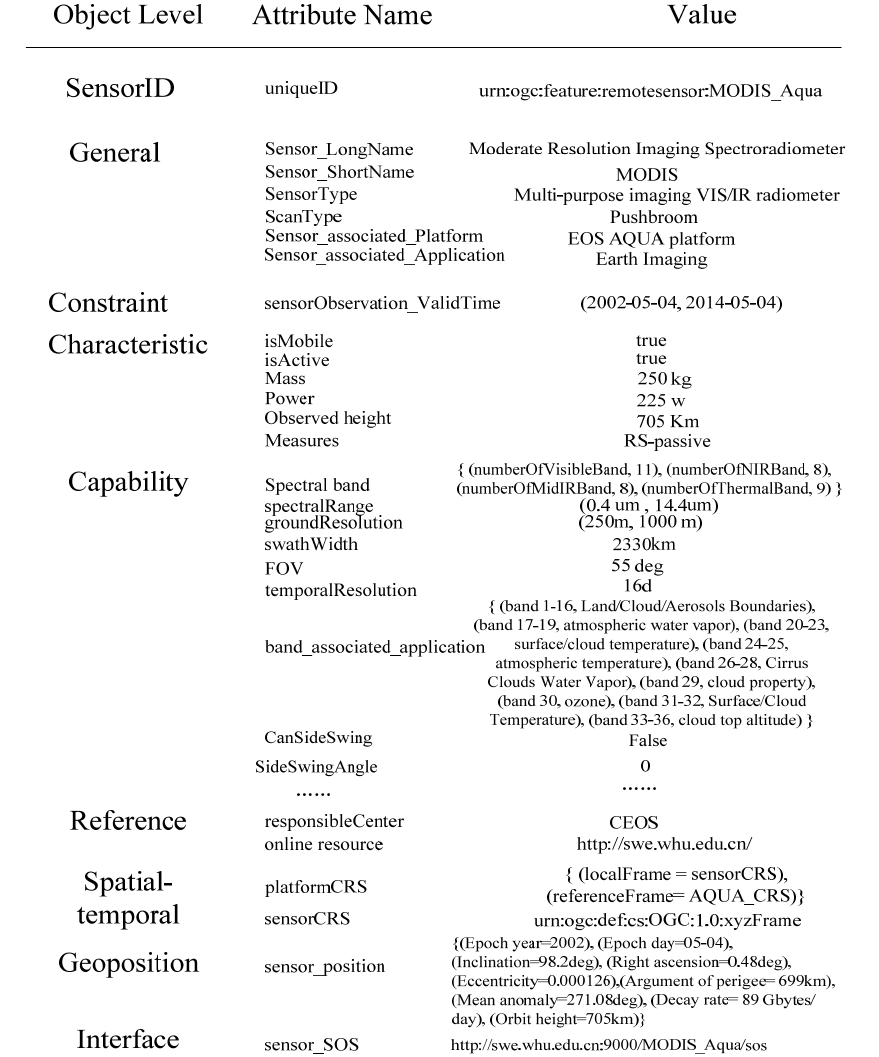
Figure 2. Assignment of meta-attribute values for the AQUA_MODIS